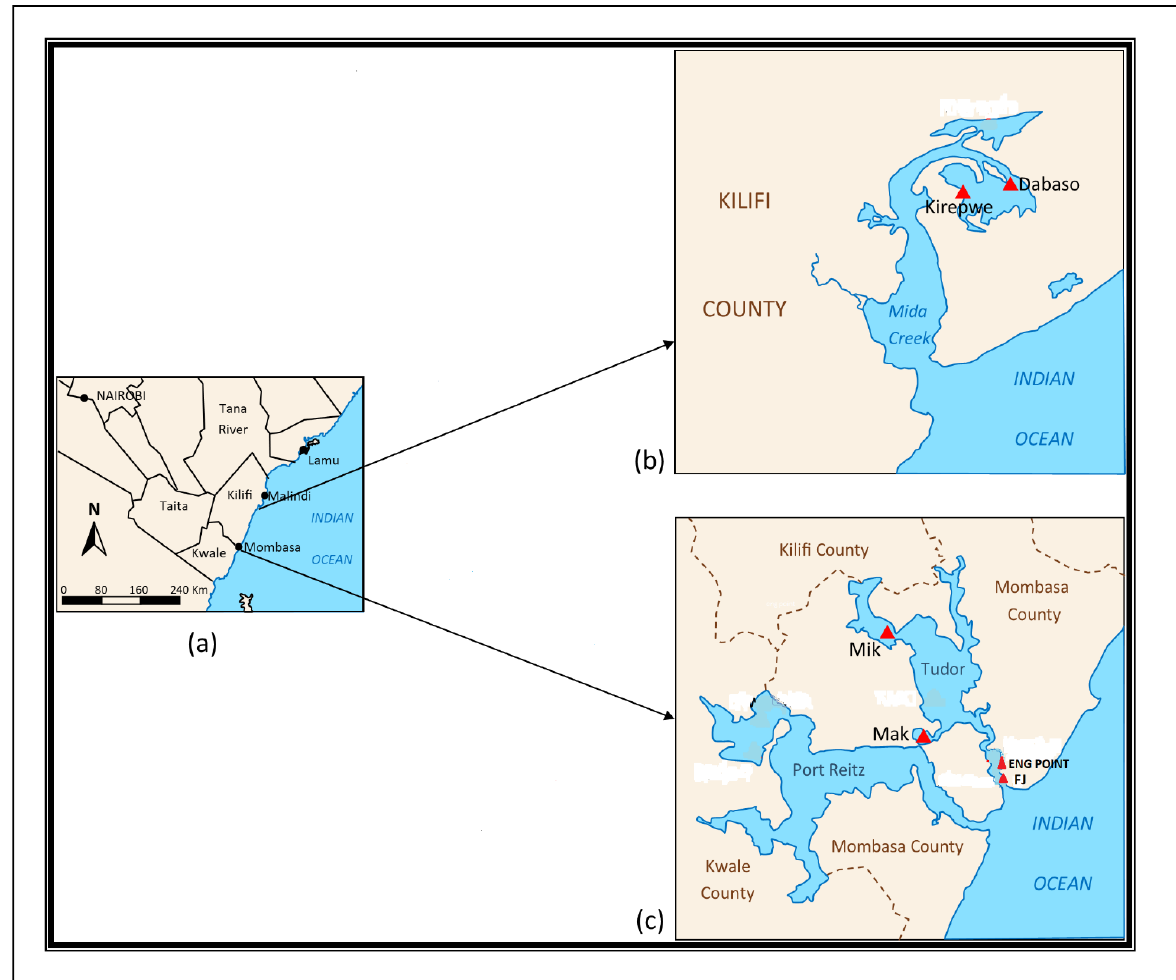
Figure 1: Map of Kenya showing the study sites (a) Kenya Coastal region; (b) Mida Creek (Dabaso and Kirepwe); (c) Mombasa Island with Tudor (Fort Jesus-FJ, English Point-Eng Point and Mikindani-Mik) and Port-Reitz (Makupa-Mak)